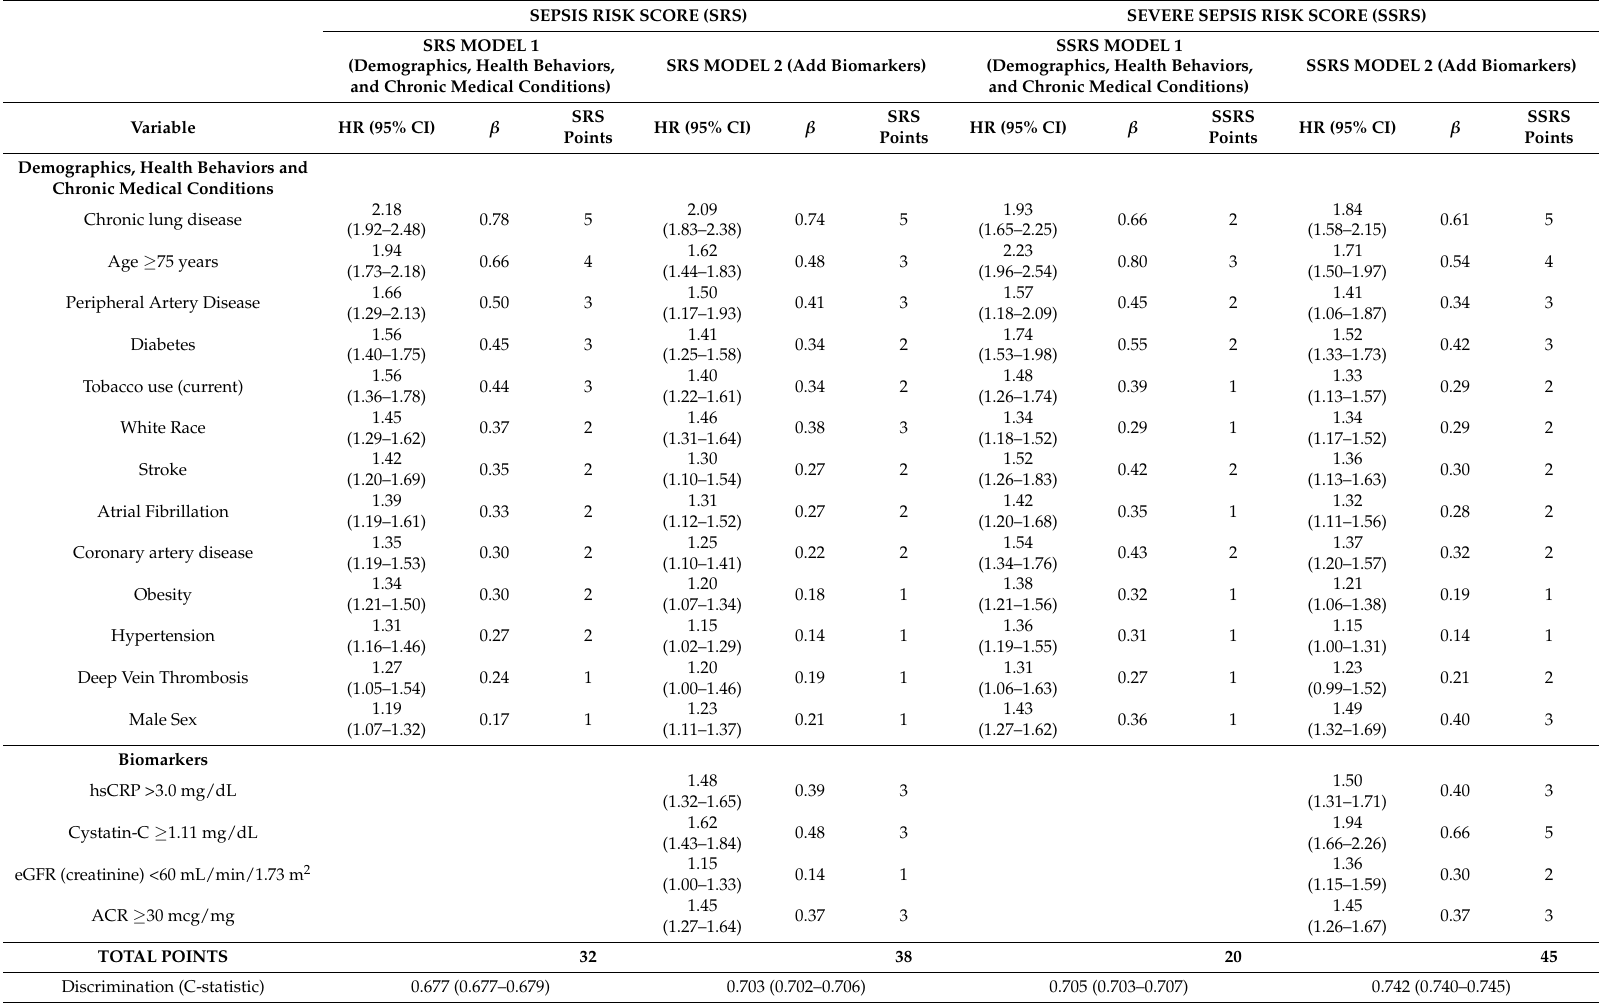
Table A1. The REGARDS Sepsis Risk Score (SRS) and Severe Sepsis Risk Score